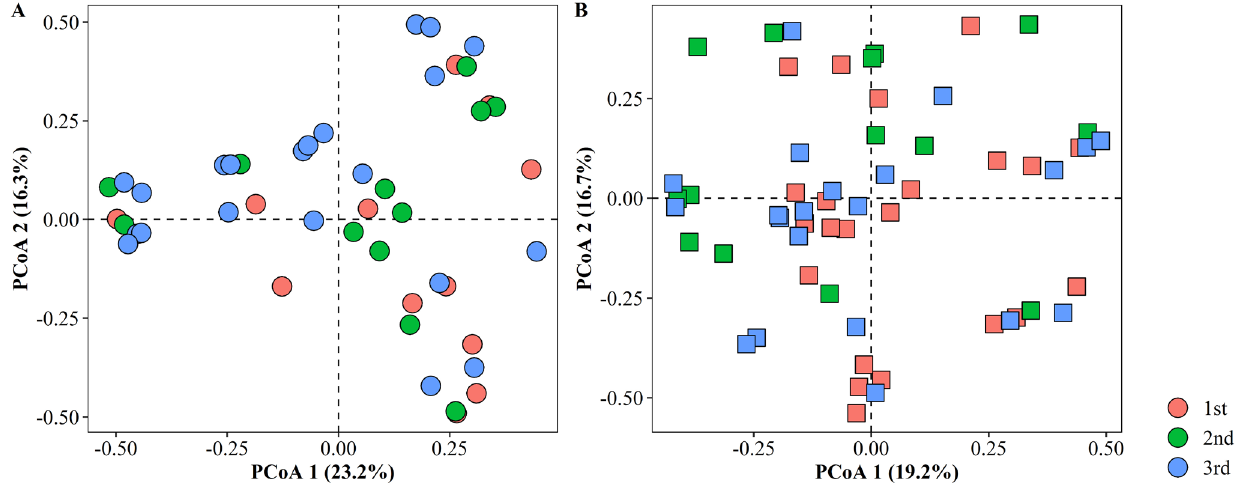
FIGURE 4 | Variation of the diet of Hyphessobrycon heterorhabdus among stream orders during A . dry and B . flood periods in eight streams of a protected area in the Eastern Amazon,